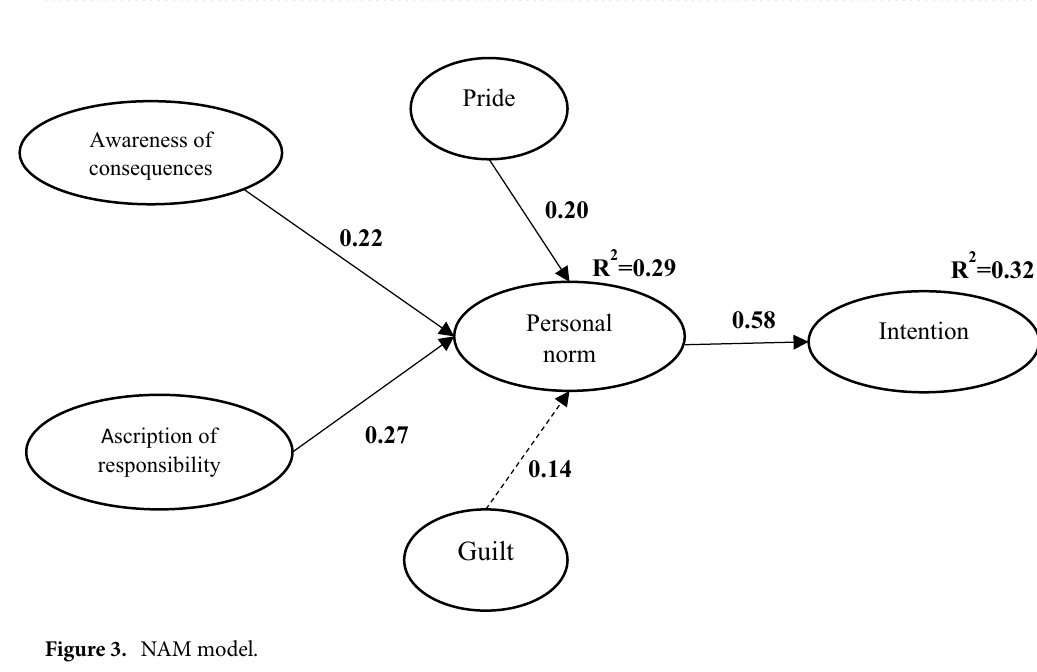
Figure 2. TRA model.